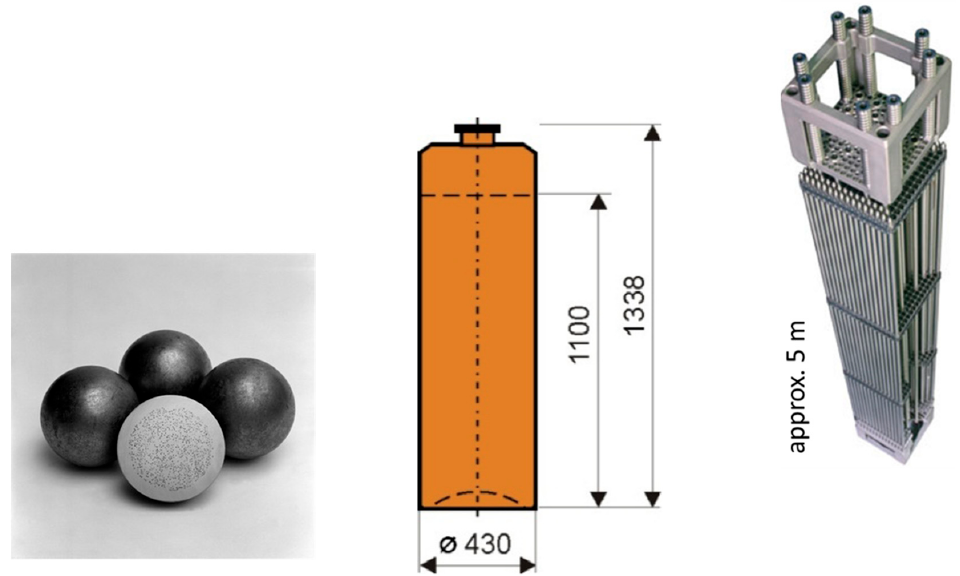
Figure 4. Types of high ‐ level radioactive waste in Germany.